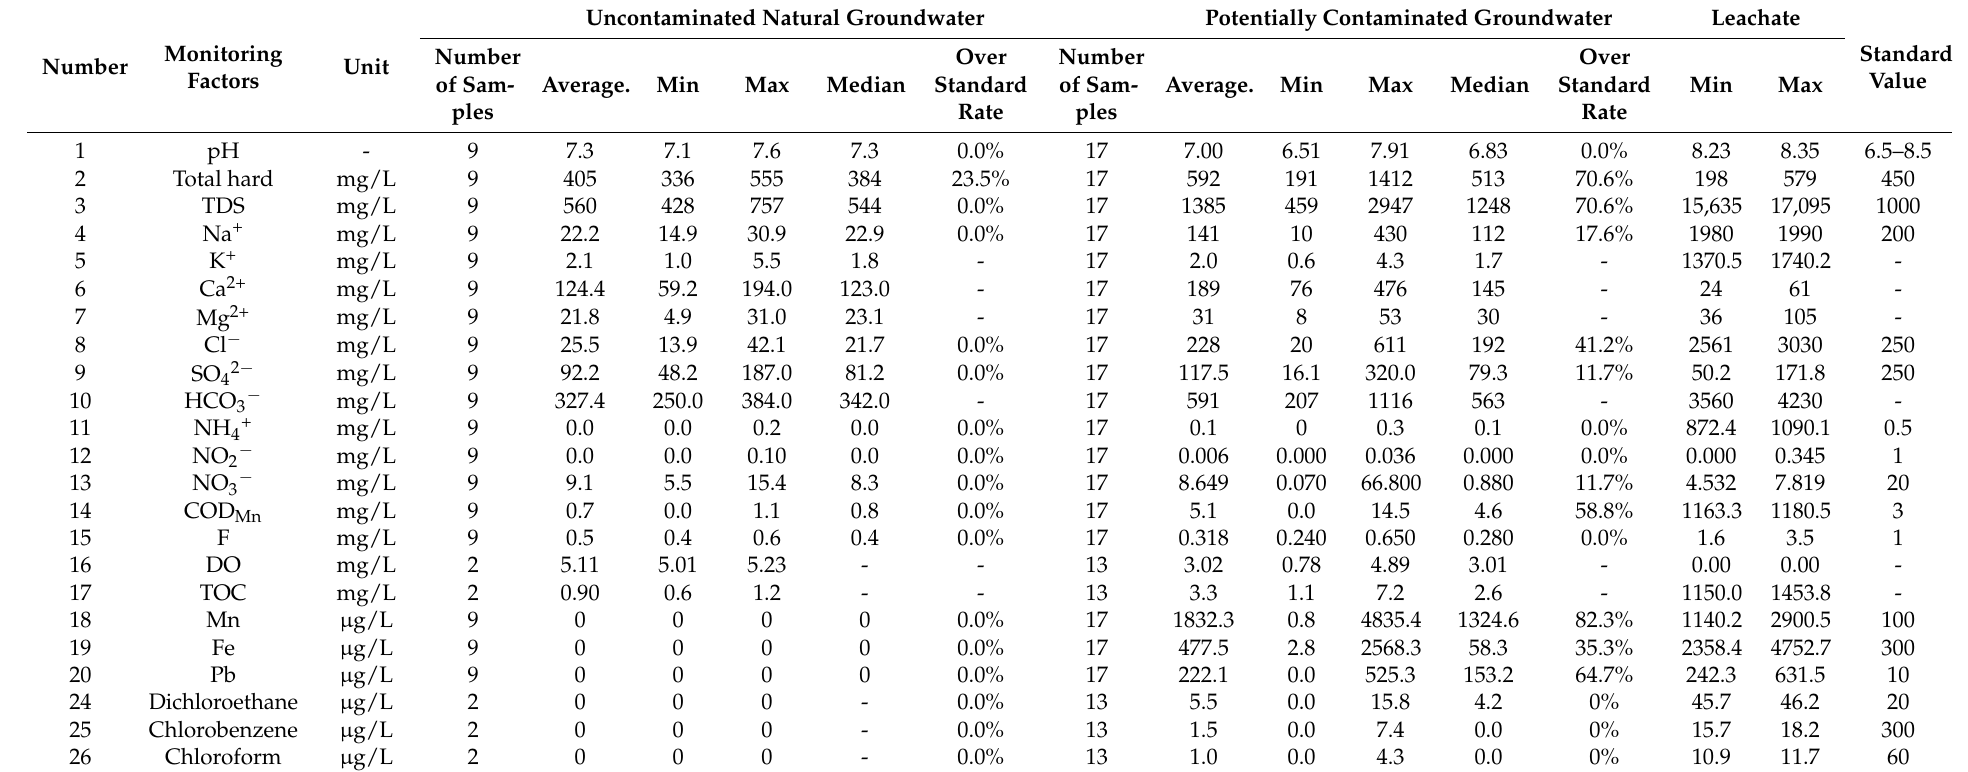
Table 4. Descriptive statistics of groundwater